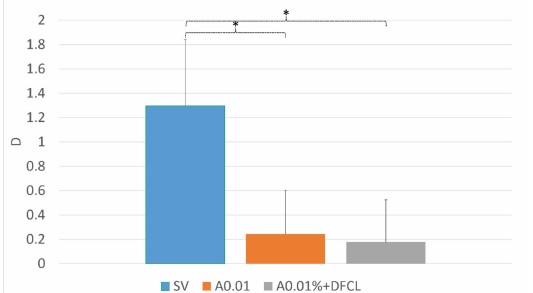
Figure 2. The rebound effect was tested one year after the cessation of treatment in the SV group, atropine at a concentration of 0.01% (A0.01) and after contact lenses with dual focus (DFCL) together with 0.01% atropine (A0.01% + DFCL). One asterisk (*) represents a significant p value ( p <